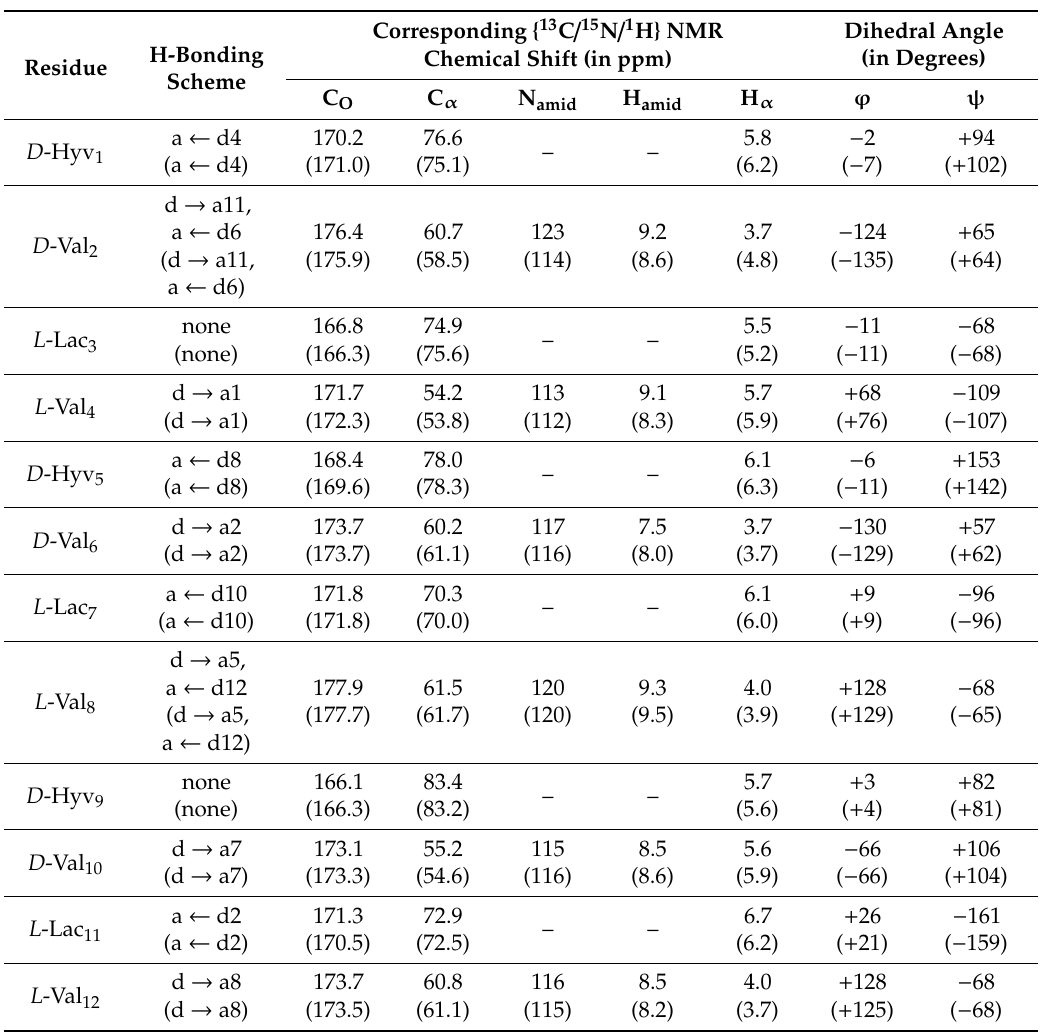
Table 1. The PW PBE structural and spectral parameters of the triclinic crystalline phase of VLM (the values for the second crystallographically independent molecule are shown in